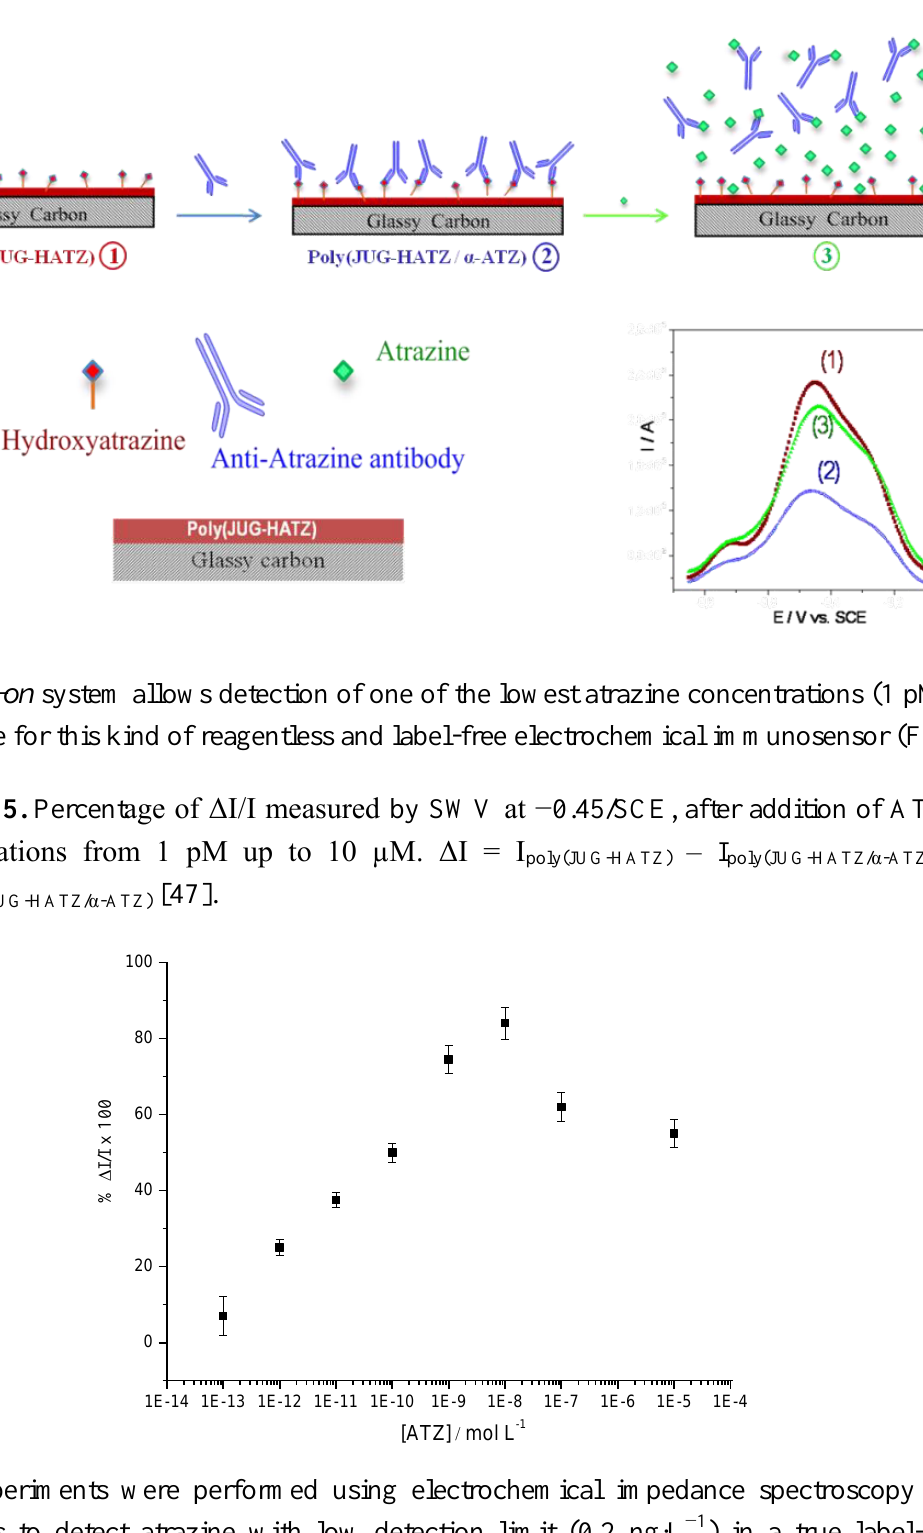
Figure 14. Immunosensor principle based on the cross-reactivity of an antibody. Example of atrazine (ATZ) detection